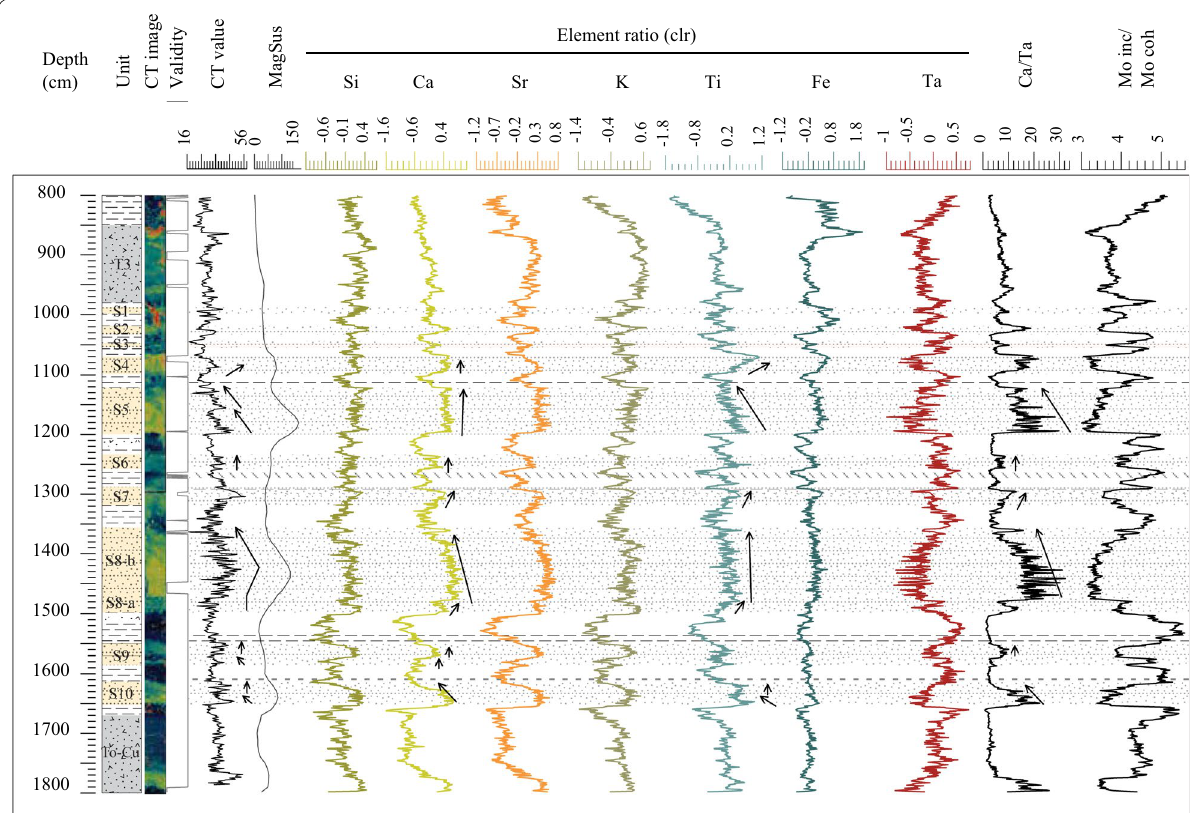
Fig. 6 Log pane of the core sample H02. Log distribution: depth, stratigraphic units, CT image, validity, CT value profile, magnetic susceptibility, and micro X‑ray fluorescence elements result (Si, Ca, Sr, K, Ti, Fe, Ta, Ca/Ta, and Inc/Coh) vs depth. Black arrows indicate trend changes in pattern